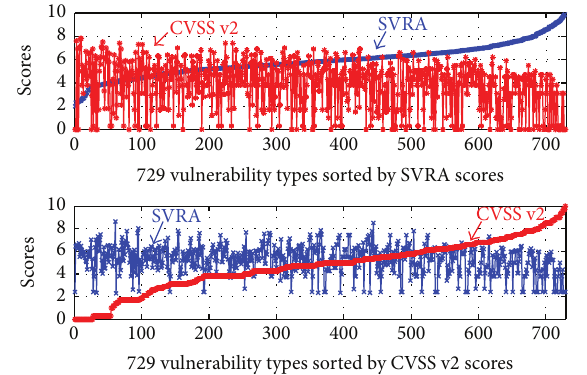
Figure 8: A theoretical score comparison of SVRA with CVSS v2 for 729 vulnerability types, where 𝑇 = {2002, 2003, . ..} and 𝑡 = 2012 .